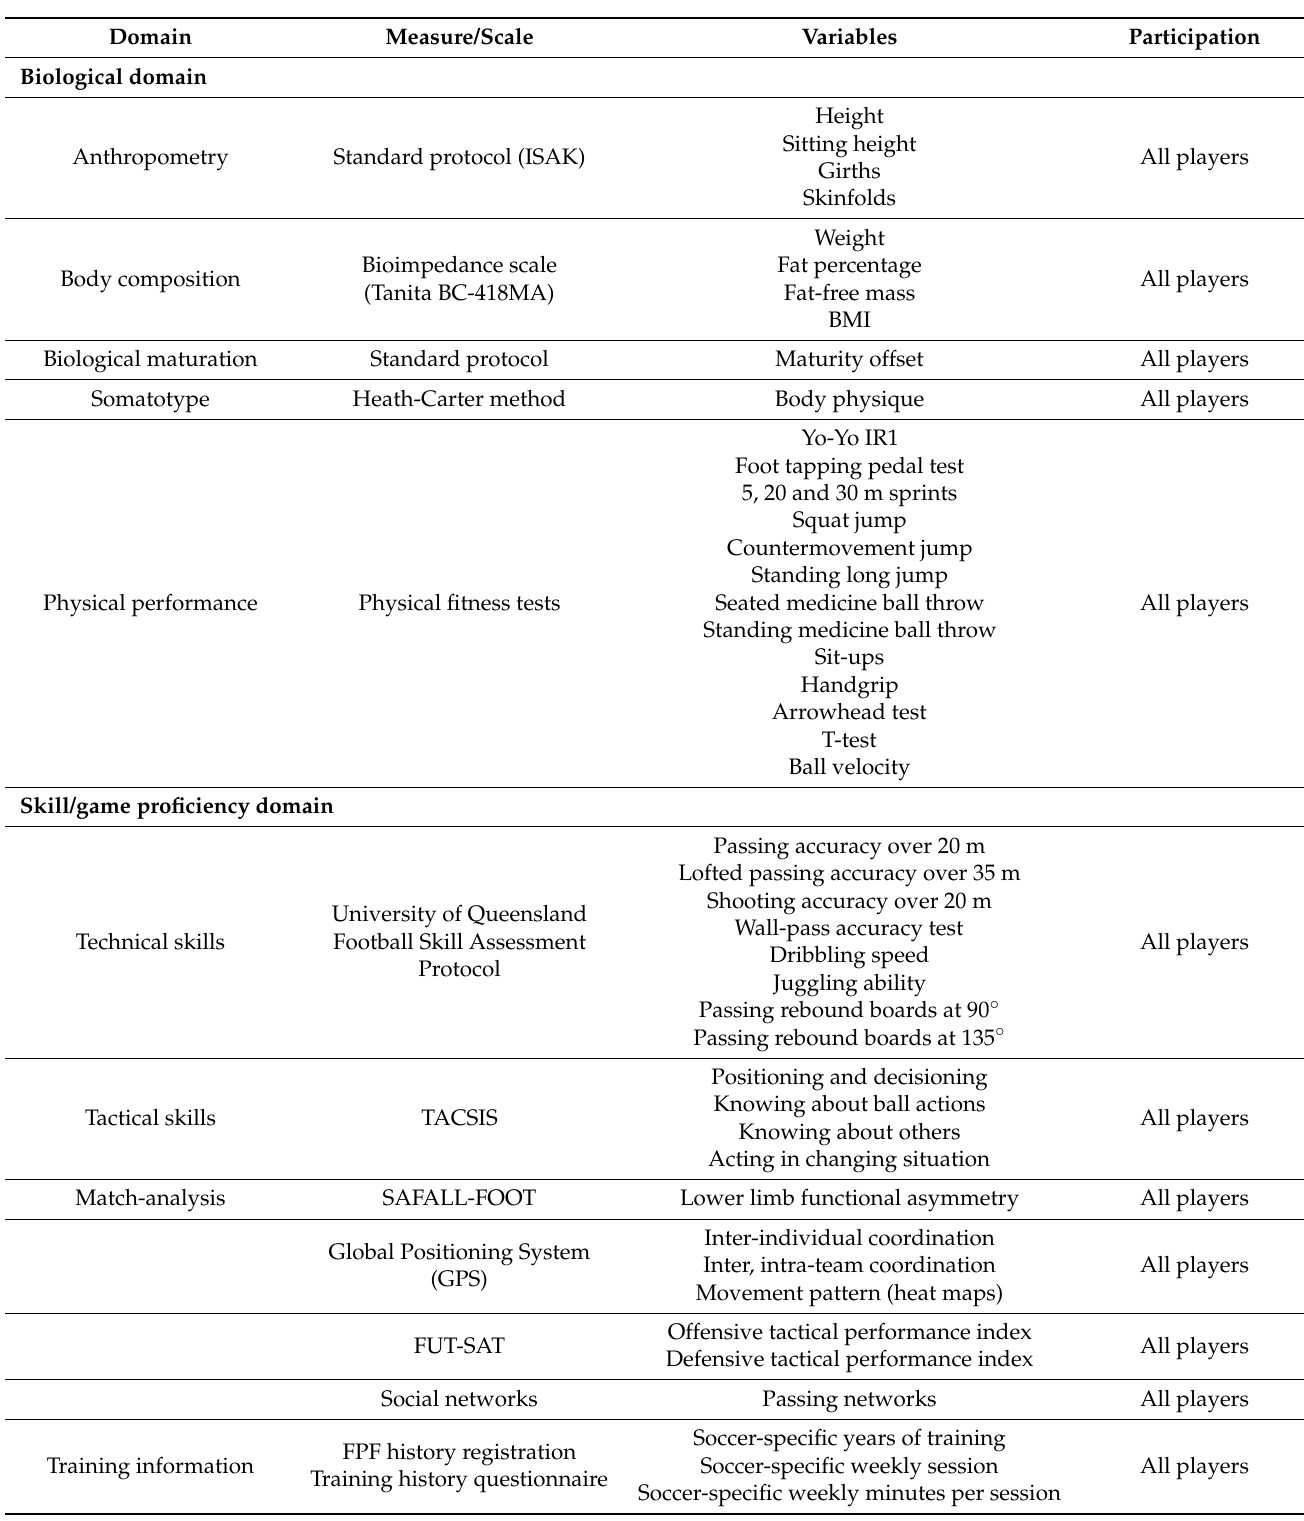
Table 2. Measures, scales, and variables of players’ and clubs’